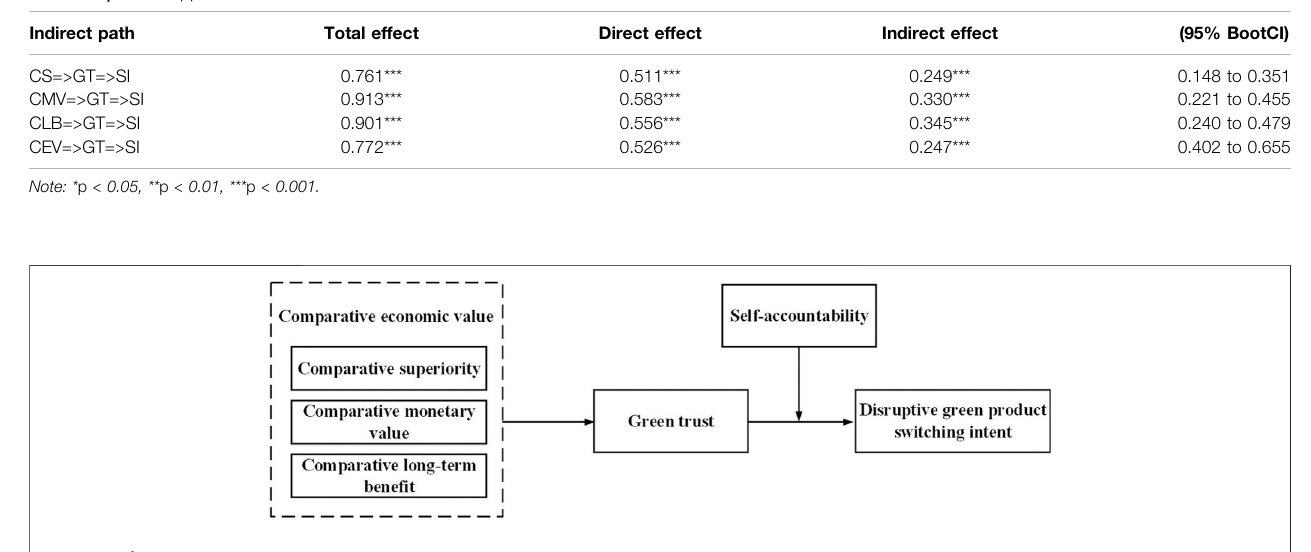
TABLE 6 | Bootstrapped result of moderation.